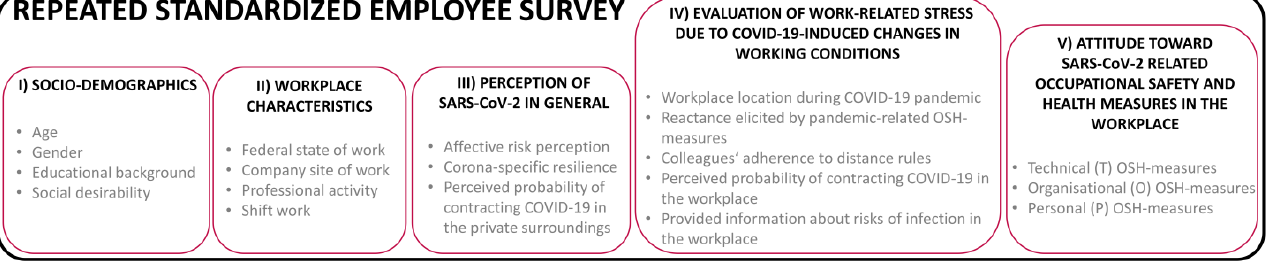
Figure 1. Main subject areas of the standardised online employee survey at